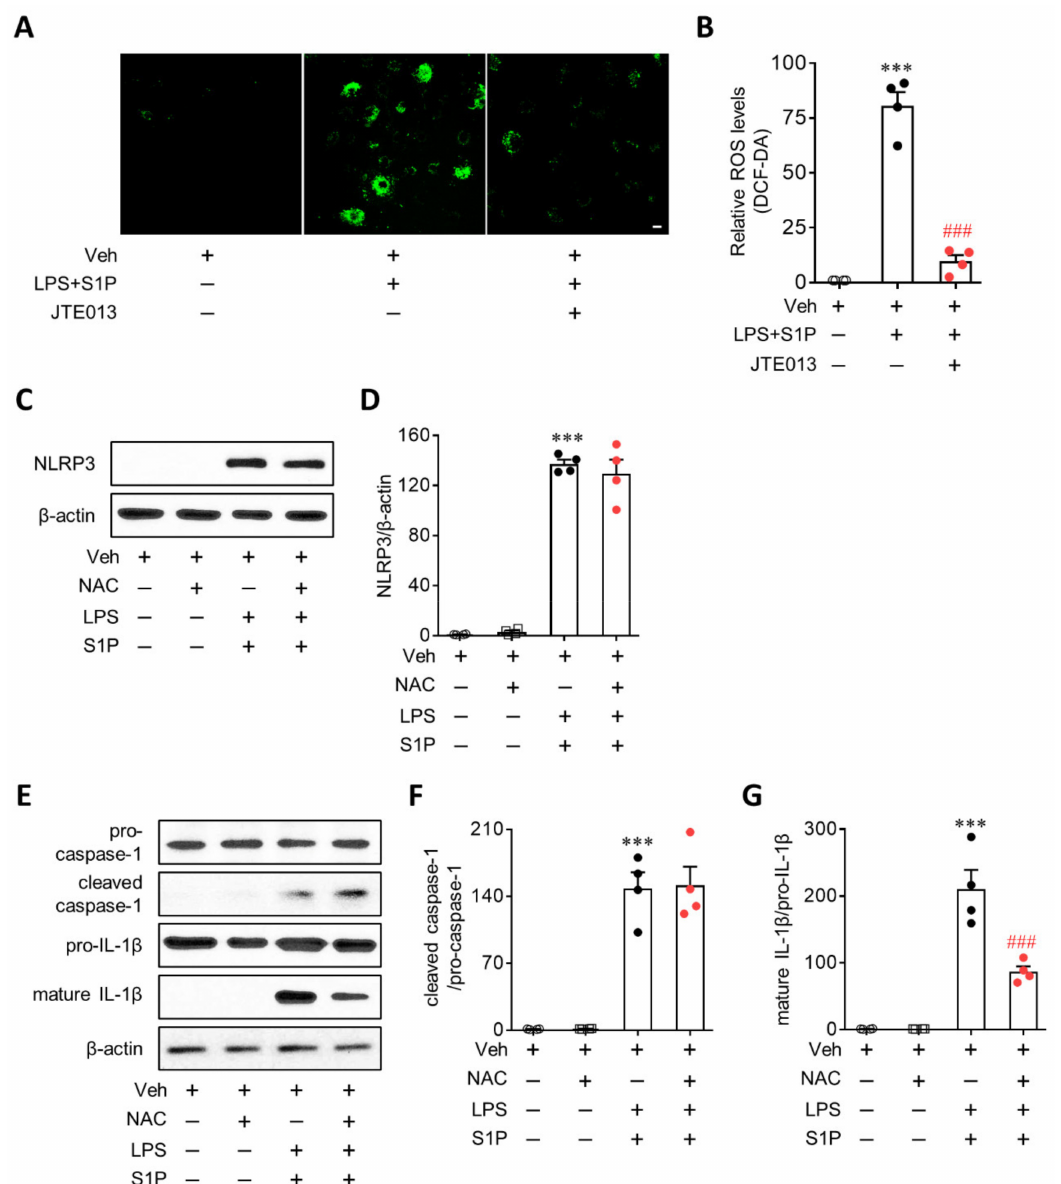
Figure 8. S1P 2 regulates intracellular ROS production from LPS-primed BMDMs followed by S1P exposure. Cells were treated with JTE013 (10 µ M) or NAC (5 mM) for 30 min. BMDMs were then primed with LPS (500 ng/mL) for 4 h and exposed to S1P (1 µ M) for 1 h. ( A , B ) Effects of JTE013 on intracellular ROS production were analyzed by DCF-DA staining of LPS/S1P-treated BMDMs (LPS + S1P). Representative images of cells bearing DCF ( A ) and quantification of ROS levels ( B ). Scale bar, 10 µ m. n = 4 per group. *** p < 0.001 versus control BMDMs (Veh). ### p < 0.001 versus LPS/S1P-treated BMDMs (LPS+S1P). ( C , D ) Effects of NAC on NLRP3 upregulation were determined by Western blot in LPS/S1P-treated